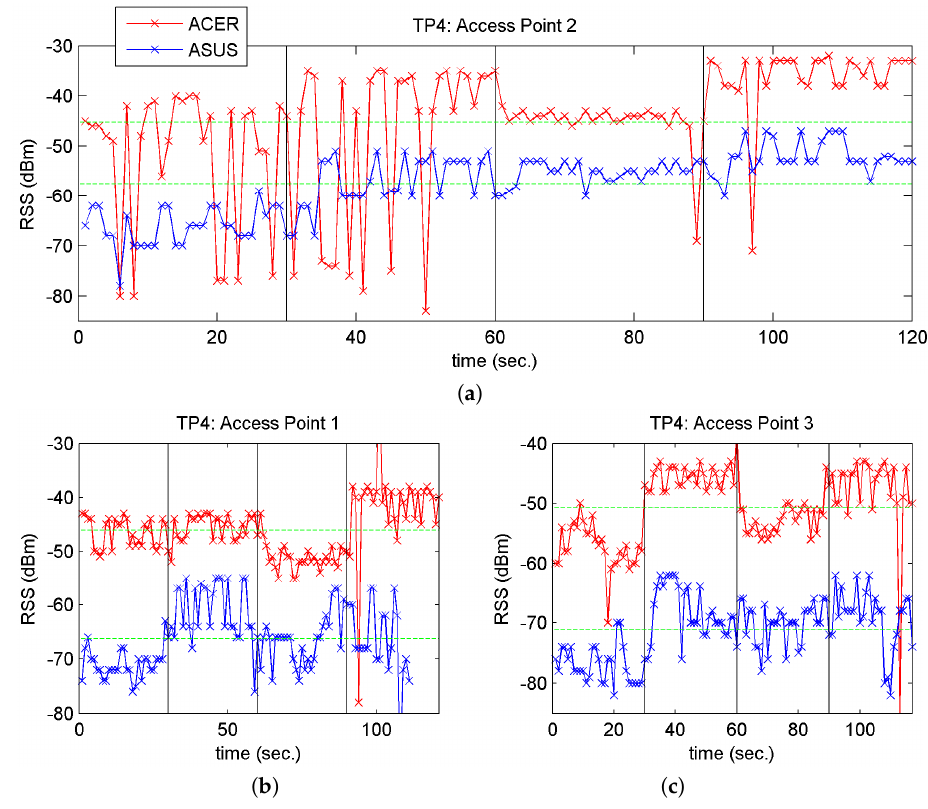
Figure 8. RSS vs. time for point TP4 and the three APs: ( a ) AP2; ( b ) AP1 and ( c )